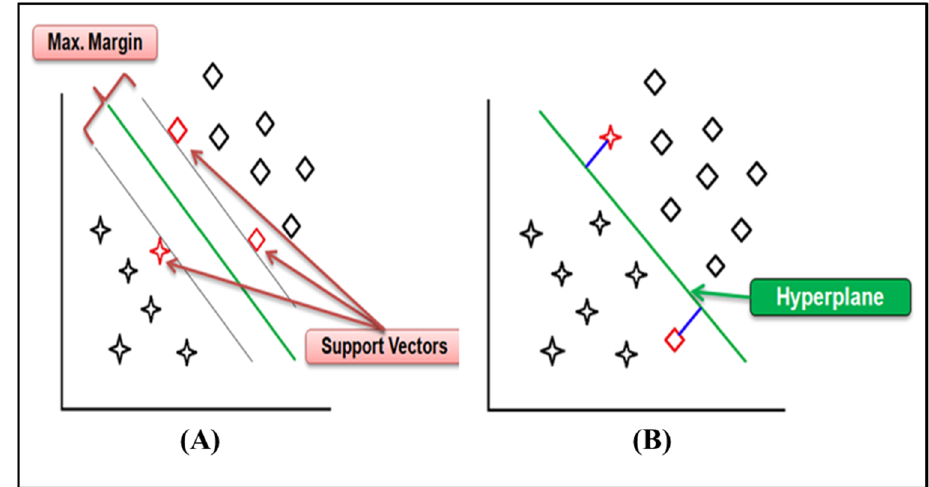
Figure 6. ( A ) 2 ‐ D SVM model and ( B ) SVM cost function. Figure 6. ( A ) 2-D SVM model and ( B ) SVM cost function.